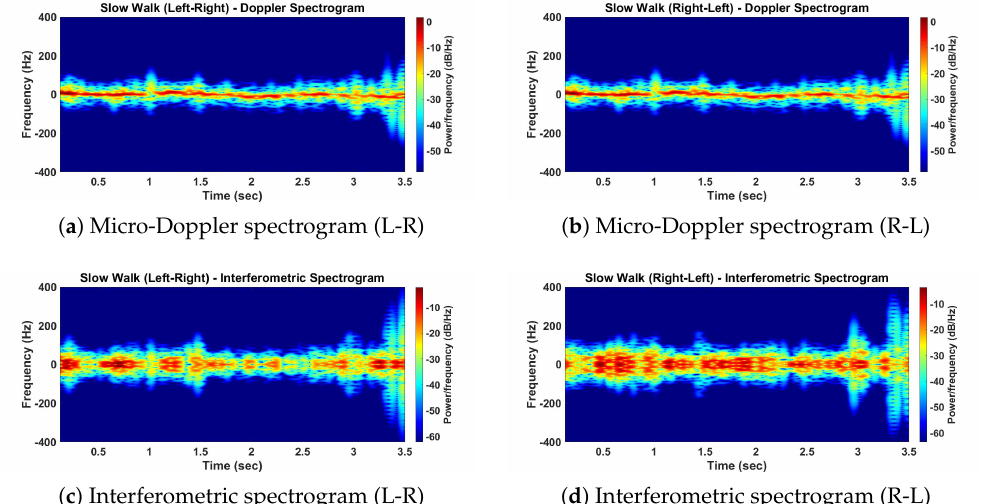
Figure 6. Dual micro-motion signatures of slow